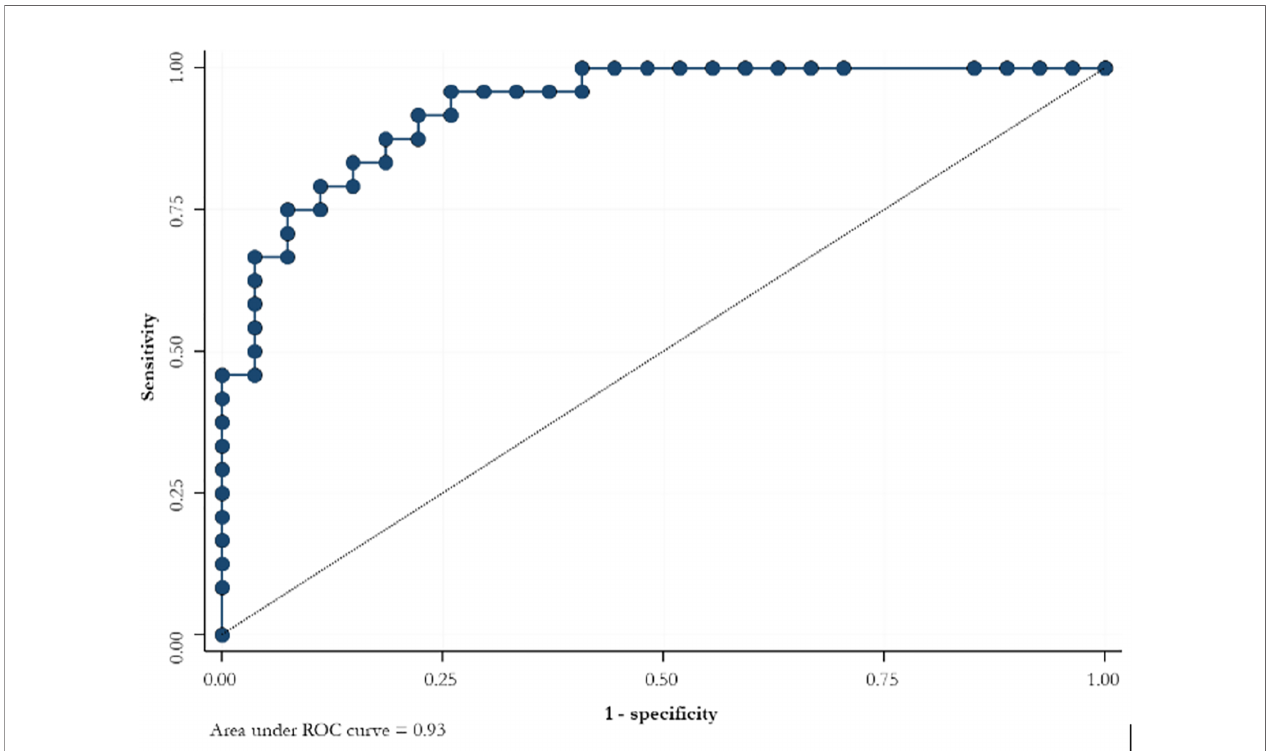
FIGURE 1 | ROC curve for the slope of serum hCG levels at 3 weeks after suction curettage to predict the persistence of trophoblastic